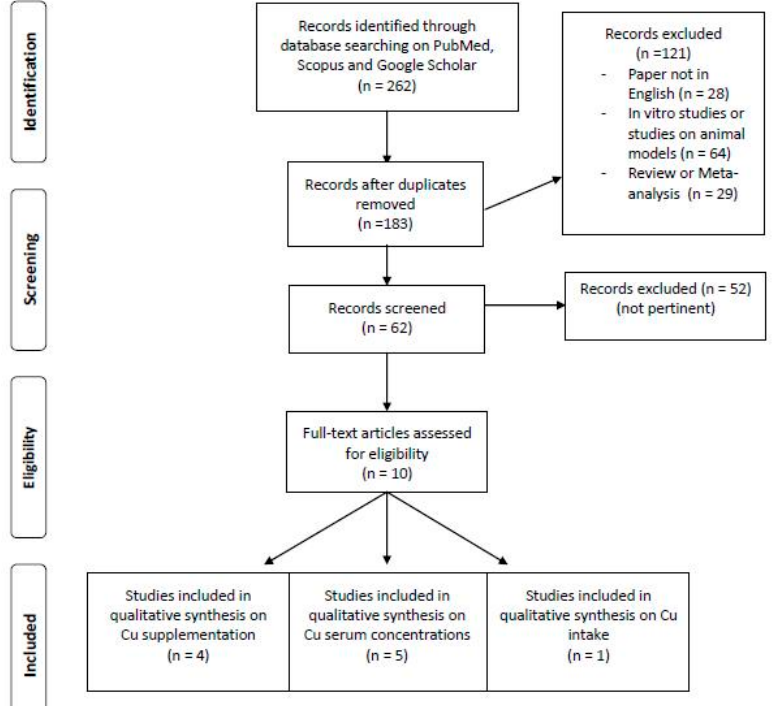
Figure 1 indicates the flow chart for the research of the literature.